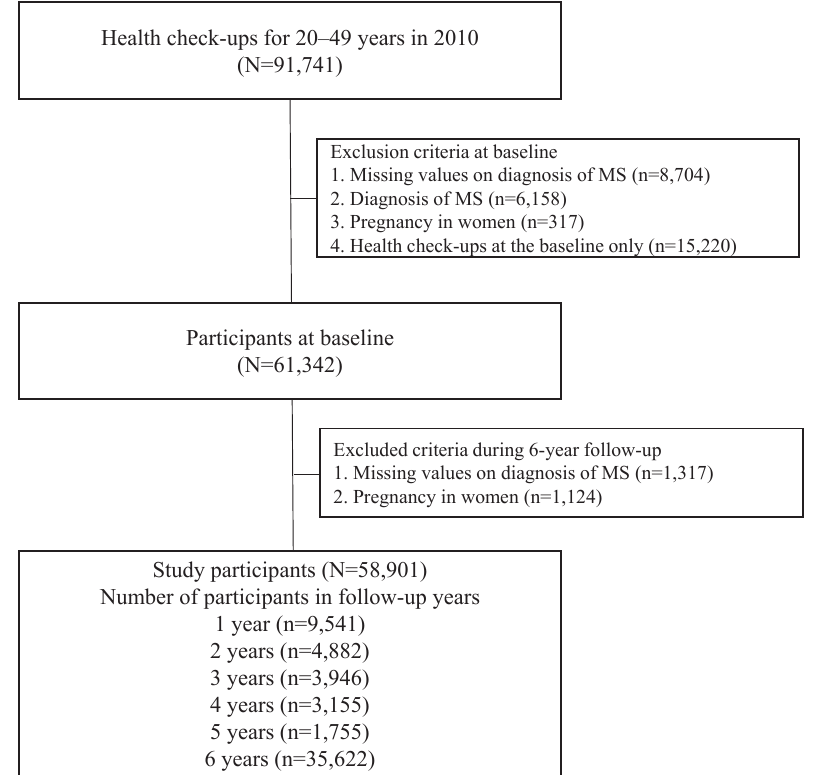
Figure 1. Flow chart of the